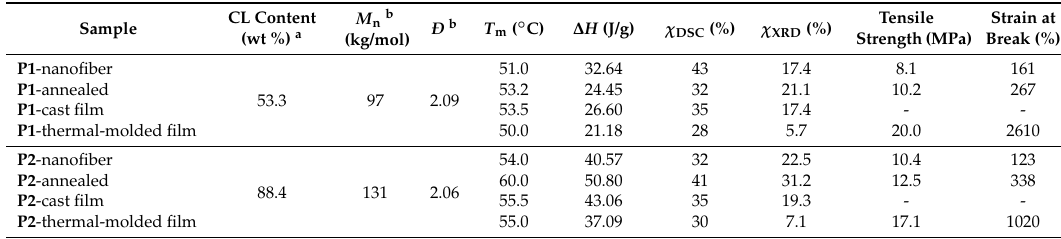
Table 1. Multi-block copolymers and their properties.